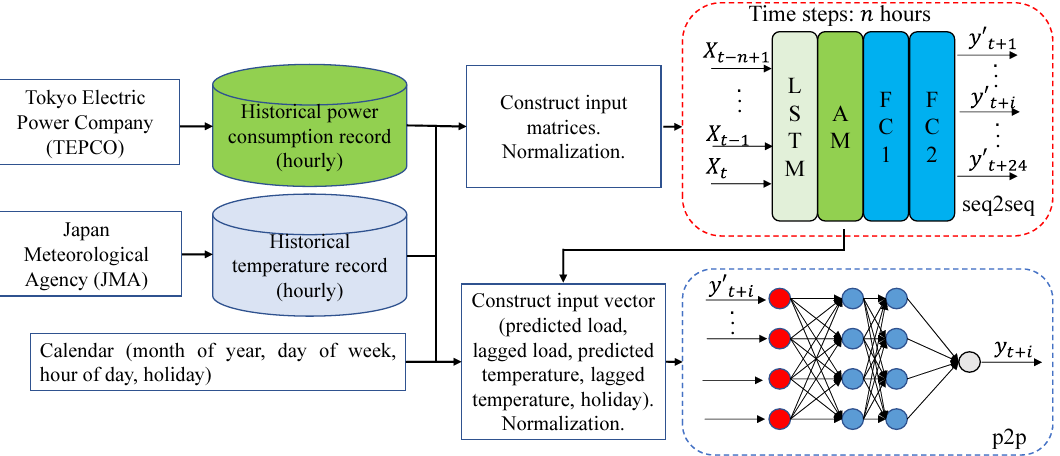
Figure 4. The framework of the two-stage short-term load forecasting (STLF)